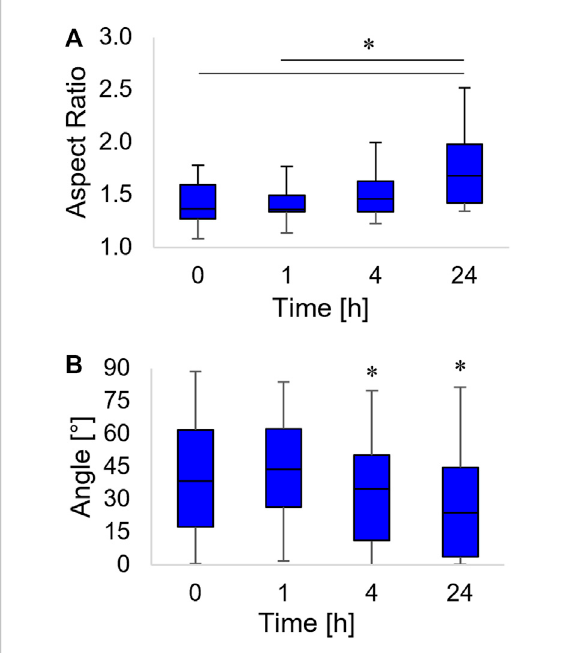
FIGURE 4 Box-and-whiskers plots of the nucleus aspect ratio (A) and the orientation of the nucleus major axis, with respect to the horizontal axis (B) . Asterisks indicate signi fi cant differences betweengroups in (A) ,whereas theyindicate that themedian value of the distribution is signi fi cantly different from 45 ° in (B)